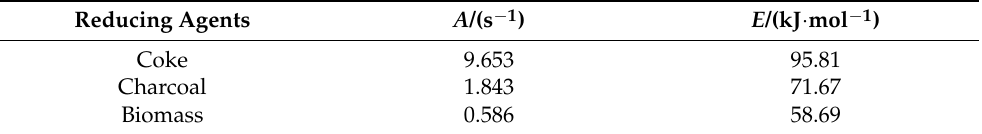
Table 4. Pre-exponential factors and apparent activation energies of different reducing